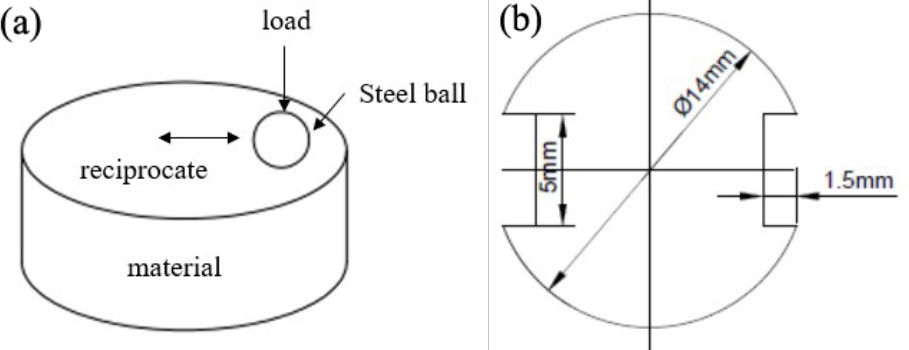
Figure 2. Diagram of friction and wear processes: ( a ) ball-on-disk contact mode; ( b ) dimensions of disk sample.